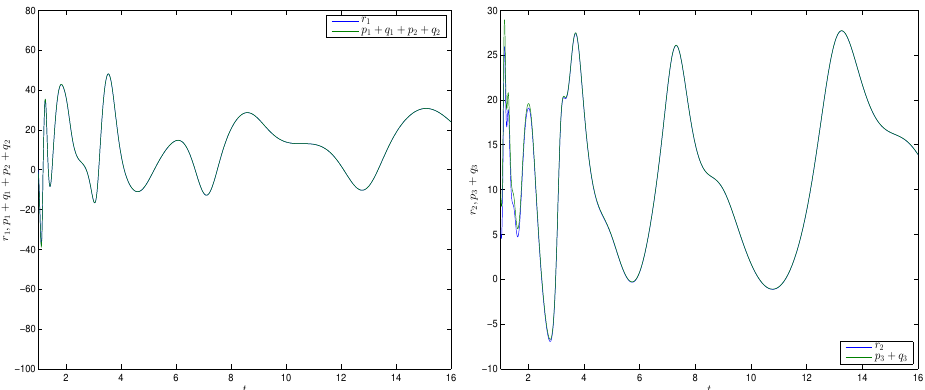
Figure 7. Time trajectories of states r 1 ( t ) , p 1 ( t ) + q 1 ( t ) + p 2 ( t ) + q 2 ( t ) and r 2 ( t ) , p 3 ( t ) + q 3 ( t ) , for Example 2.